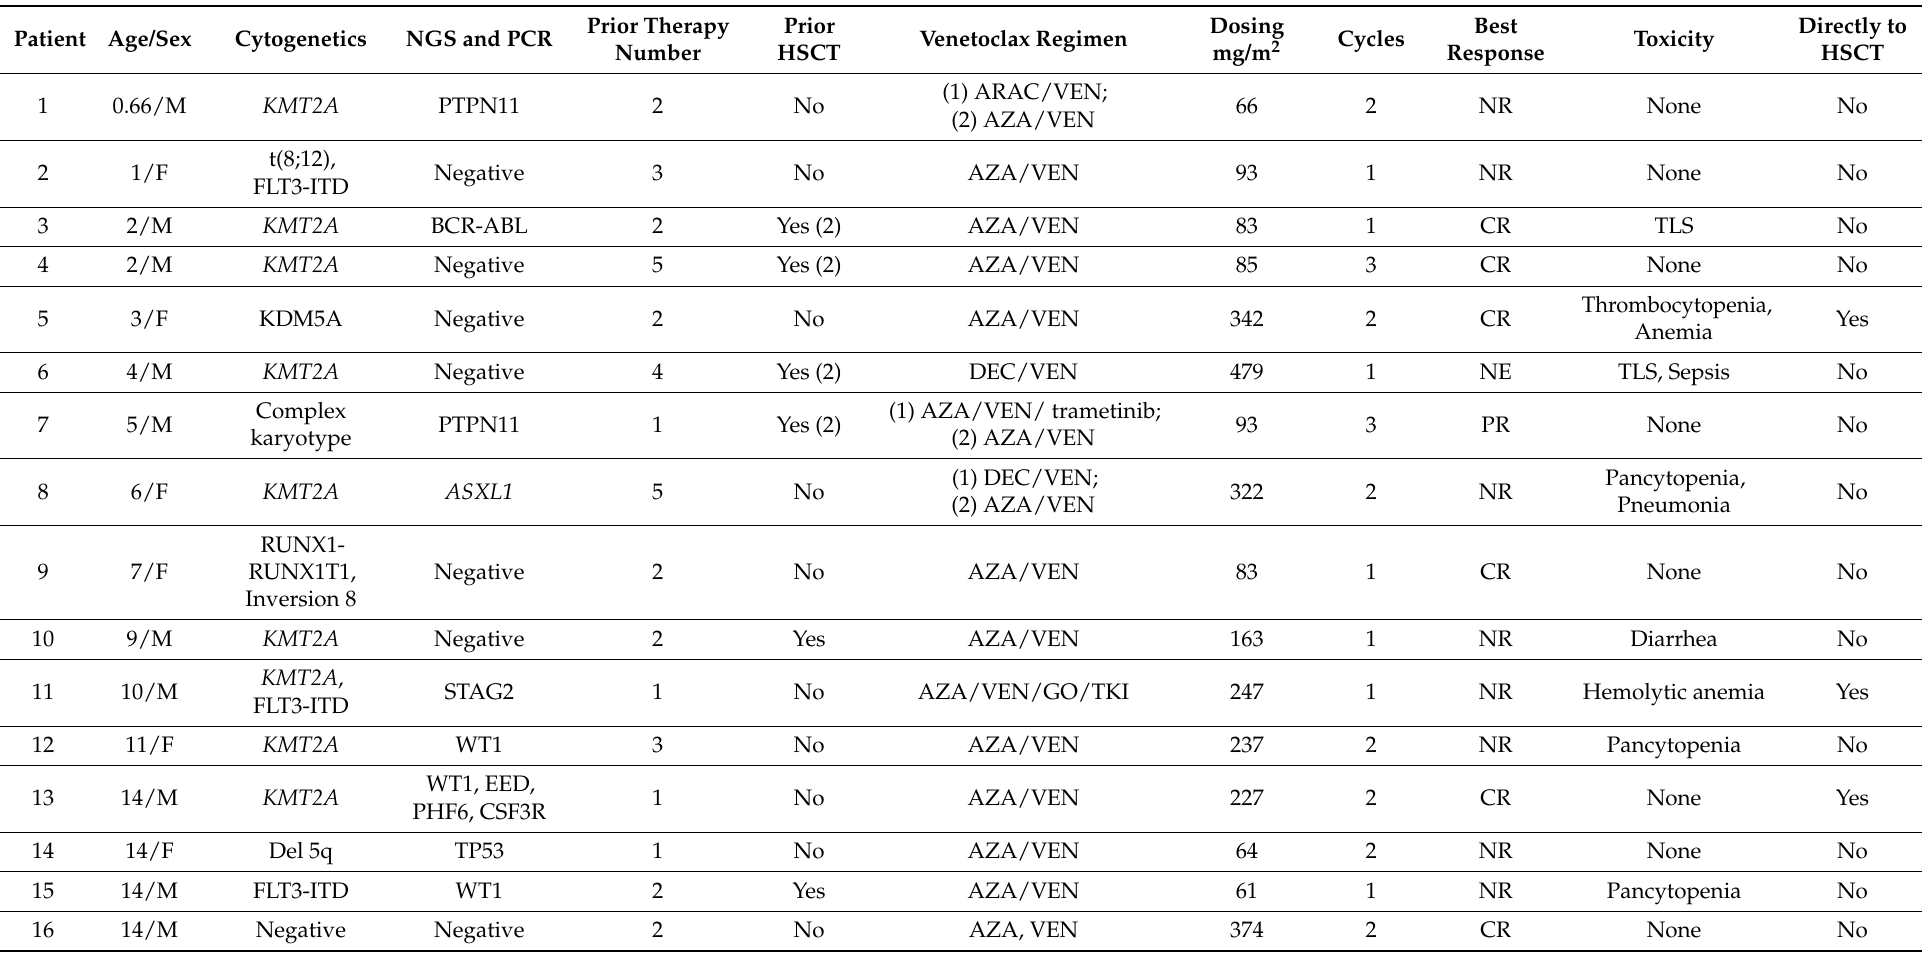
Table 2. Patient disease characteristics, concurrent therapy, dosing for venetoclax, number of cycles given, response, toxicity, and HSCT